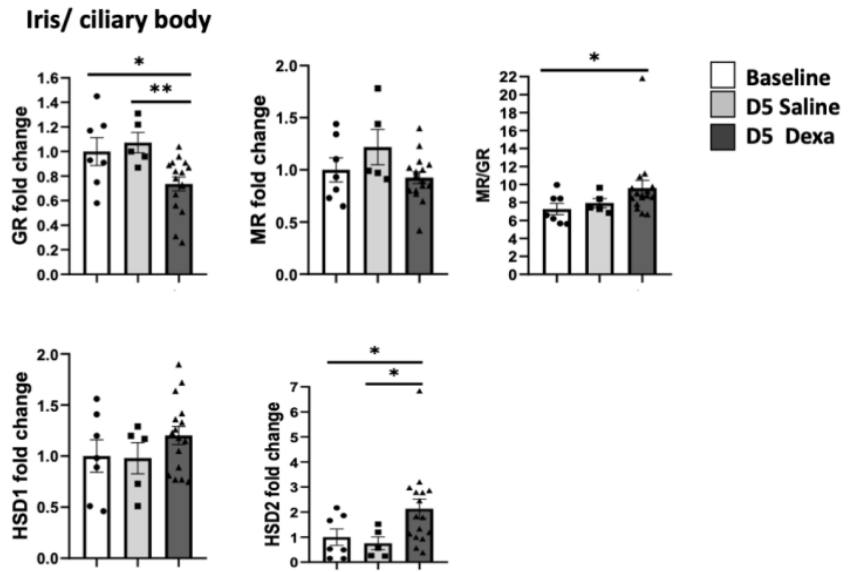
Figure 3. Corticoid receptors and hydroxysteroid dehydrogenase gene expression in the iris/ciliary body. Nr3c1 , encoding GR, Nr3c2 encoding MR and 11β -hsd1 and 2 expression at baseline ( n = 7), after 5 days of daily injection of dexamethasone ( n = 16), or saline ( n = 6), * p < 0.05, ** p < 0.01. 2.3. Regulation of MR-Induced Genes in the Retina and RPE/Choroid